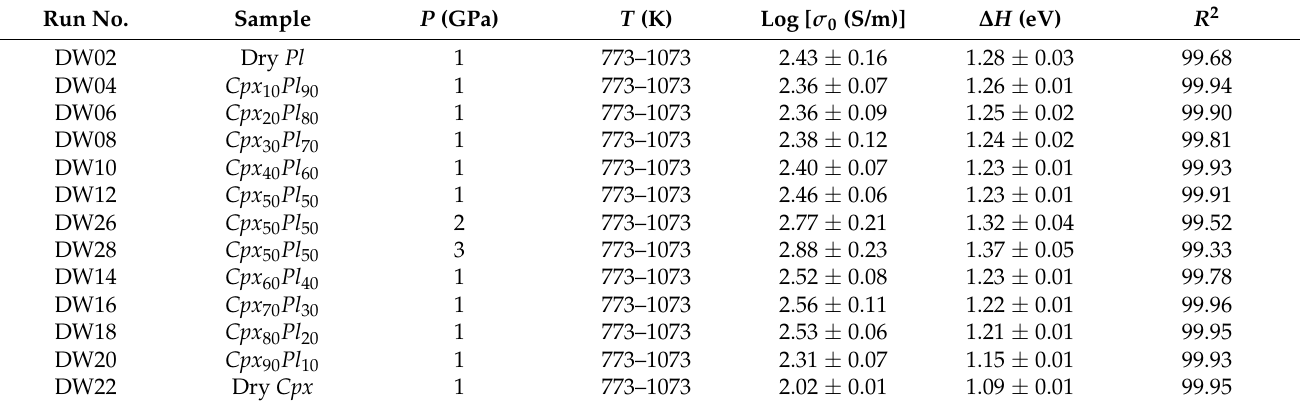
Figure 4. Typical complex impedance spectra for the Cpx 50 Pl 50 sample, obtained at temperatures of 773–1073 K and pressure of 1.0 GPa in the frequency range from 10 − 1 Hz to 10 6 Hz. Z (cid:48) and Z (cid:48)(cid:48) are the real and imaginary parts of the complex impedance, respectively. The equivalent circuit that is composed of the series connection of R S -CPE S and R E -CPE E ( R S and CPE S represent the resistance and the constant-phase element of the bulk impedance for the sample, respectively; R E and CPE E represent the resistance and the constant phase element from the polarization effect of the sample-electrode interface, respectively) is selected to model the impedance semicircles. The fitting results for the experimental data are displayed by using the solid line. Table 2. Fitted parameters of the Arrhenius relation for the electrical conductivity of dry hot-pressed sintering gabbro samples. P is pressure, T is temperature, σ 0 is the pre-exponential factor, ∆ H is activation enthalpy, and R 2 is the linear